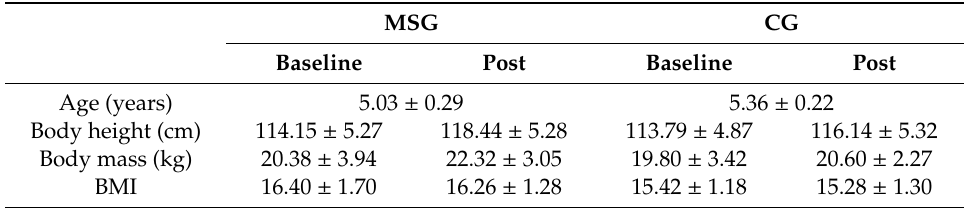
Table 2. Bodyweight status pre- and post-intervention.